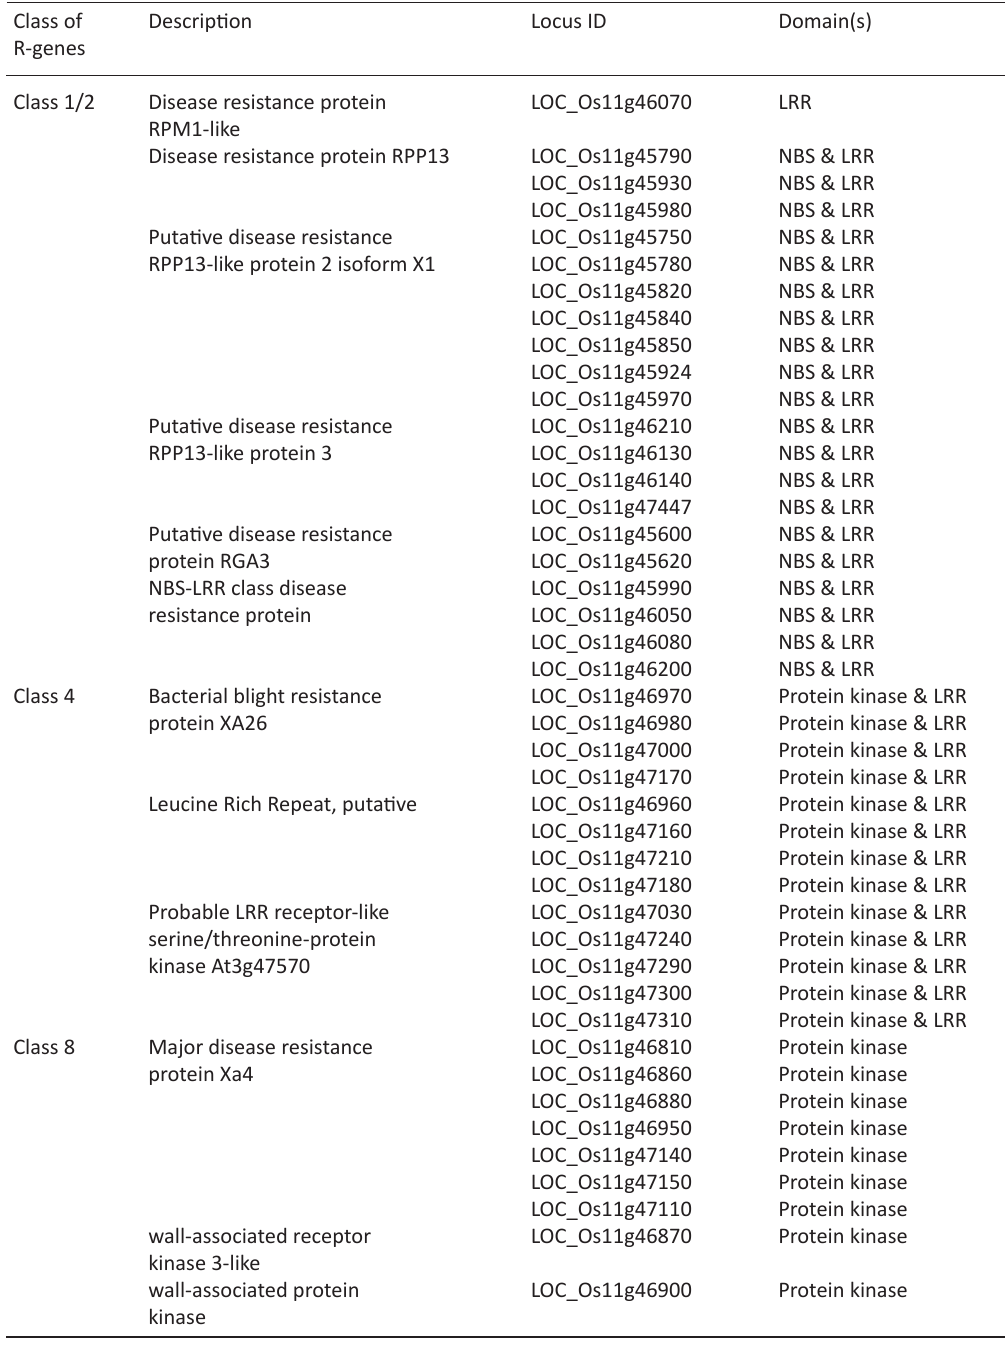
Table 1. List of R-genes in qBBR11-1 with respect to domains Class